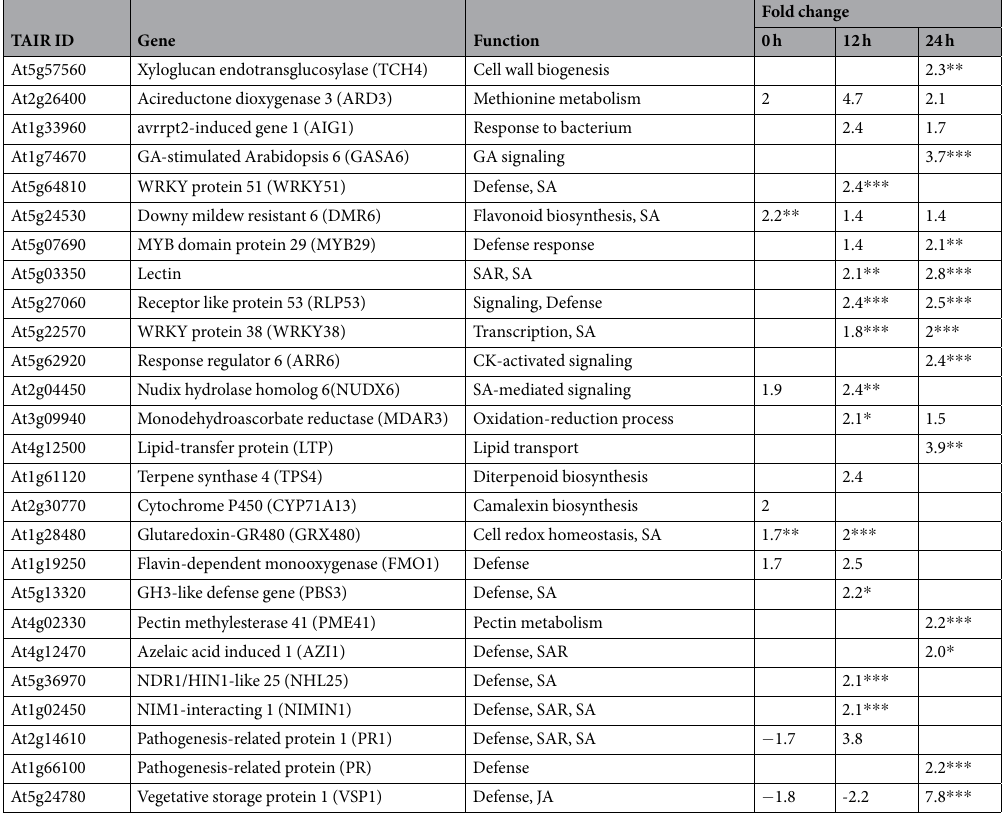
Table 1. List of selected genes which are involved in defense and phytohormone signaling. Numbers indicate the fold changes observed through microarray experiment. Genes are responsive to salicylic acid (SA), jasmonic acid (JA), gibberellic acid (GA), cytokinin (CK), and systemic acquired resistance (SAR). P- value ranges are marked by asterisks: *** P < 0.01, ** 0.01 < P < 0.05, * P <